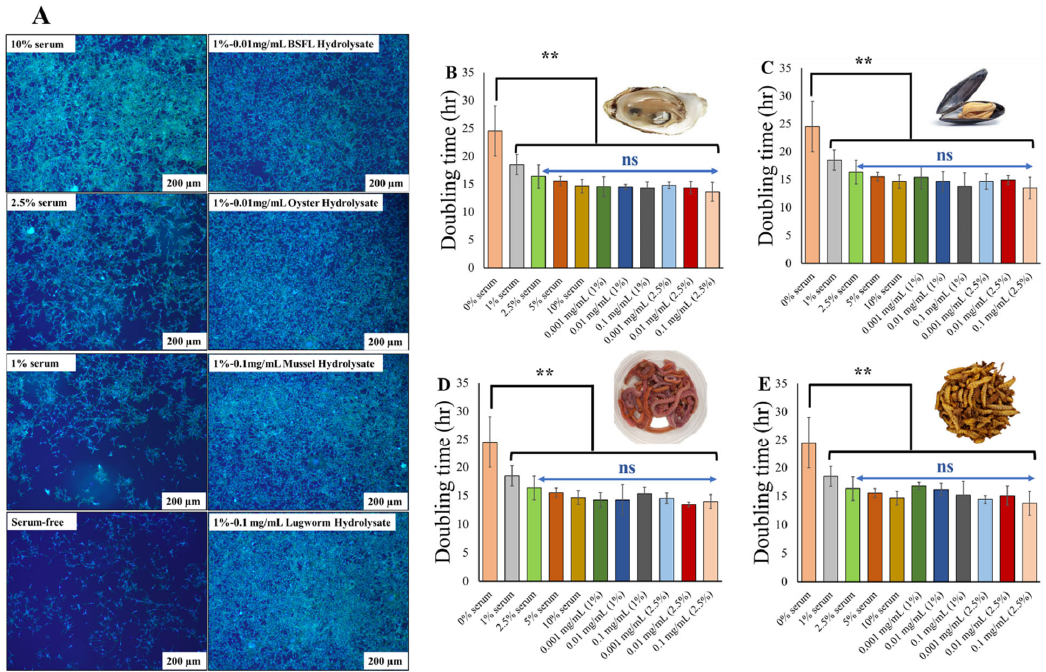
Figure 7. ( A ) Hoechst and actin green fluorescent staining of cells at all serum concentrations and protein hydrolysate conditions. Only selected concentrations of protein hydrolysates in combination with 1% serum were used for imaging; Doubling time (h) for protein hydrolysates at low concen- trations (0.001, 0.01, and 0.1 mg/mL) in combination with low serum concentrations (1 and 2.5%), negative control (serum-free) and positive control (10% serum), for oyster ( B ); mussel ( C ); lugworm ( D ); and BSF ( E ). ns: non-significant; (**) significant ( p <